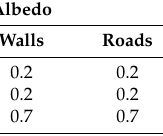
Table 3. Labels and description of the numerical experiments.